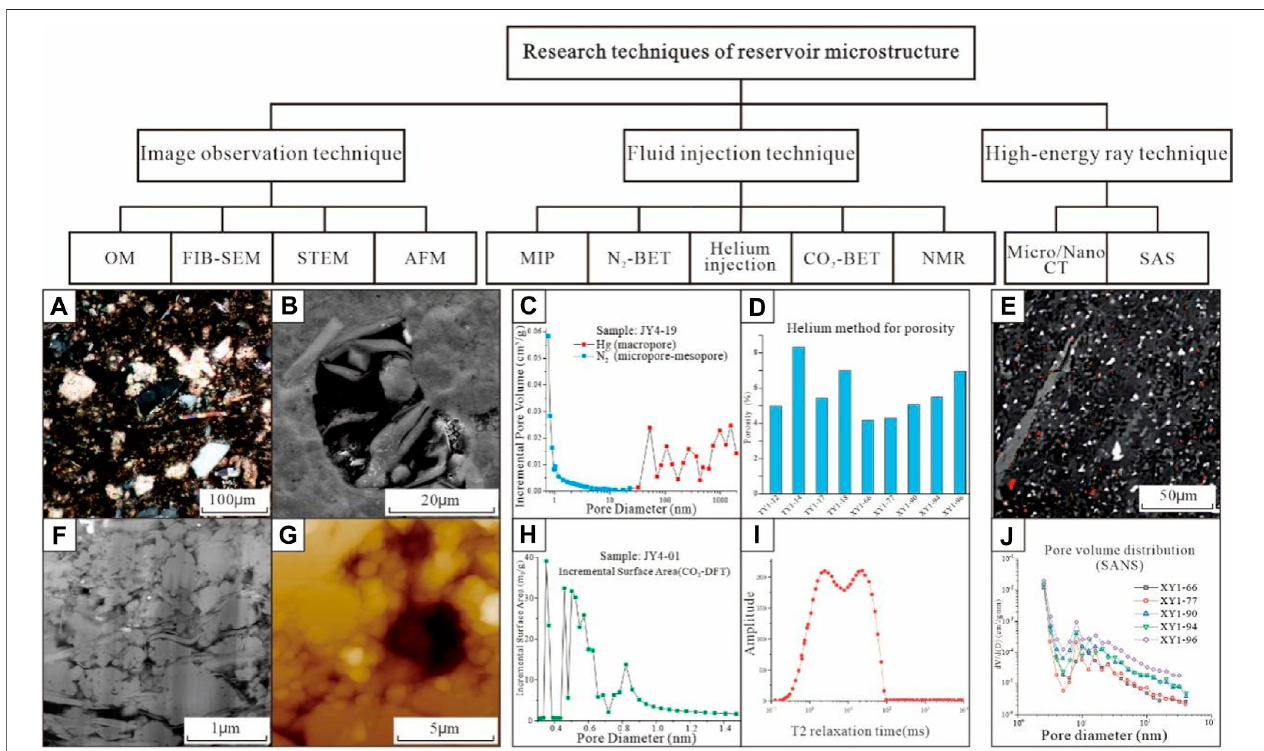
FIGURE 3 | Research method of reservoir microstructure. (A) Distribution of components in N228 shale under orthogonal polarization; (B) Focused ion beam – scanning electron microscopy images of pore fractures and minerals in XHY-1; (C) Characterization of shale pore distribution by mercury injection and nitrogen adsorption; (D) Porositymeasuredbyheliuminjection; (E) Two-dimensionaldistributionofshaleminerals andfracturesundermicro CT(Gouet al.,2019); (F) Shale dark fi eldscanningtransmissionelectronmicroscopyimage(Pengetal.,2014); (G) JY4-05(WufengFormation,2591.7 m)shalesurfacetopographyunderatomicforce microscopy; (H) The surface area distribution of carbon dioxide adsorption; (I) Nuclear magnetic resonance of water-saturated shale (Sun et al., 2012); and (J) Shale pore volume distribution under small angle neutron scattering (Sun M. et al., 2017)).